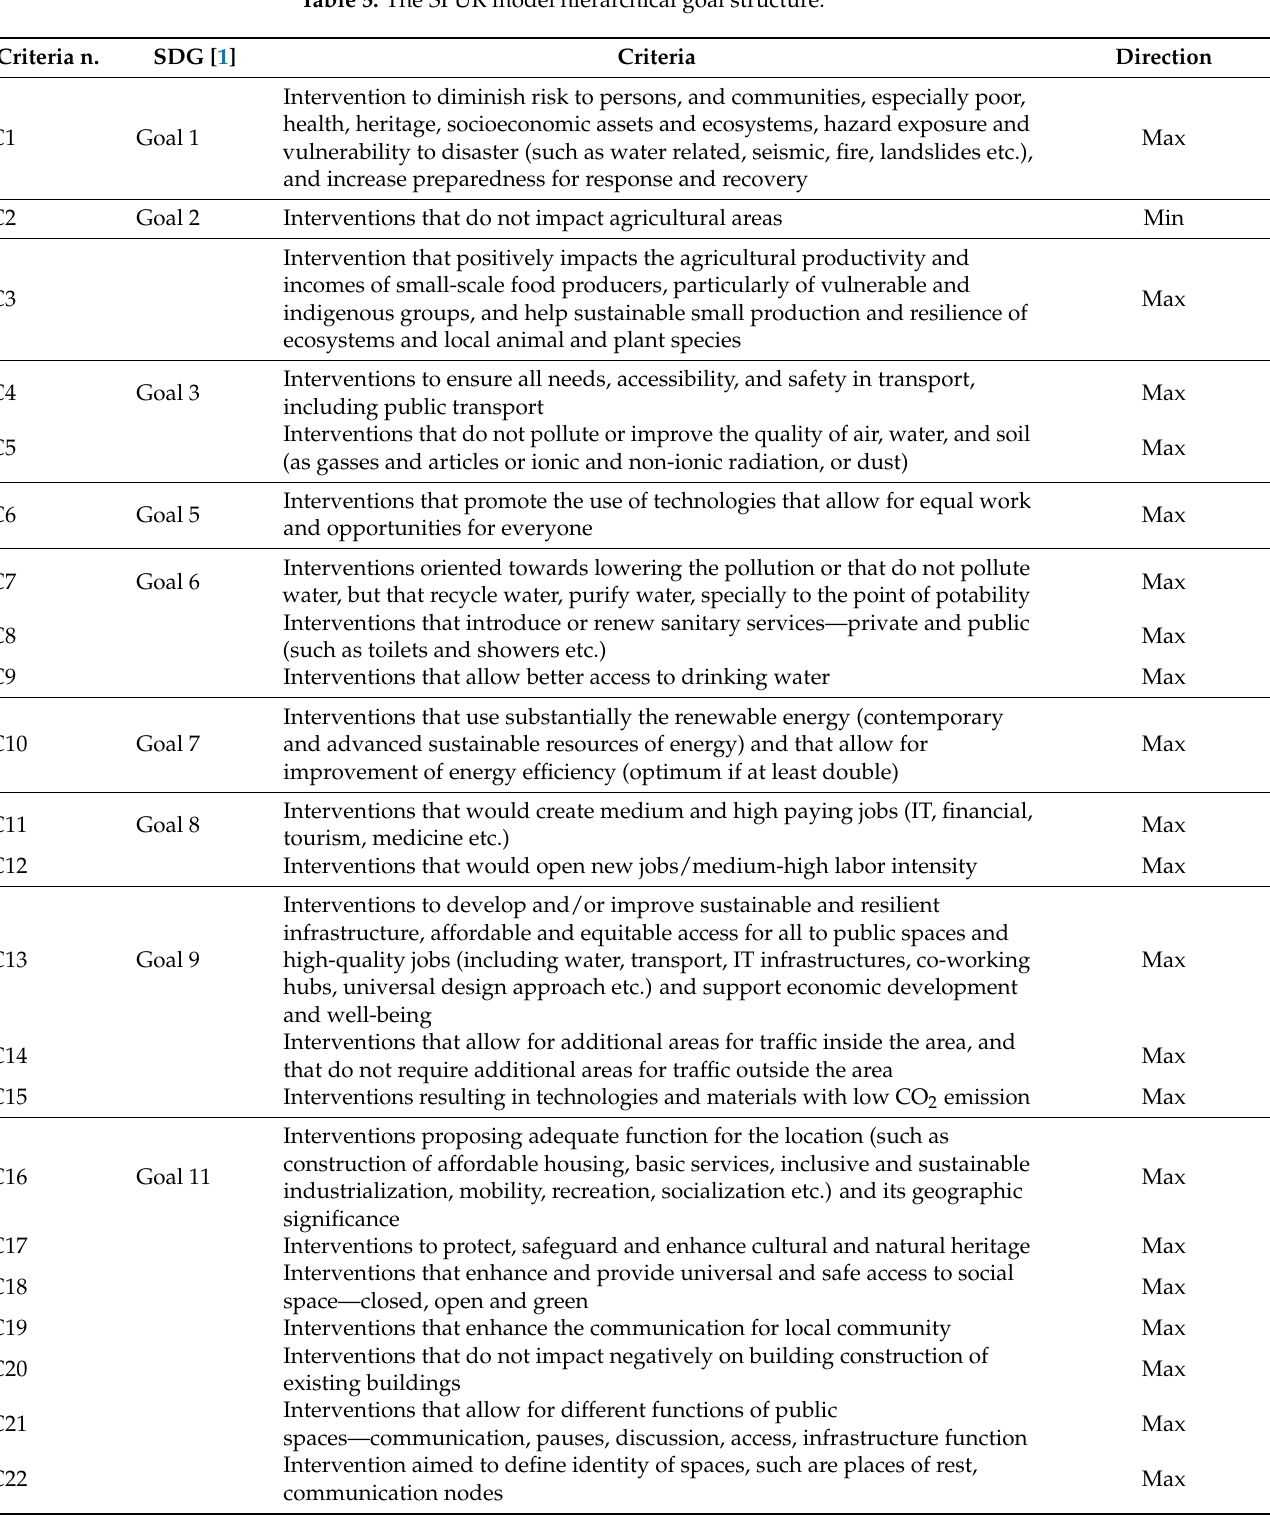
Table 5. The SPUR model hierarchical goal